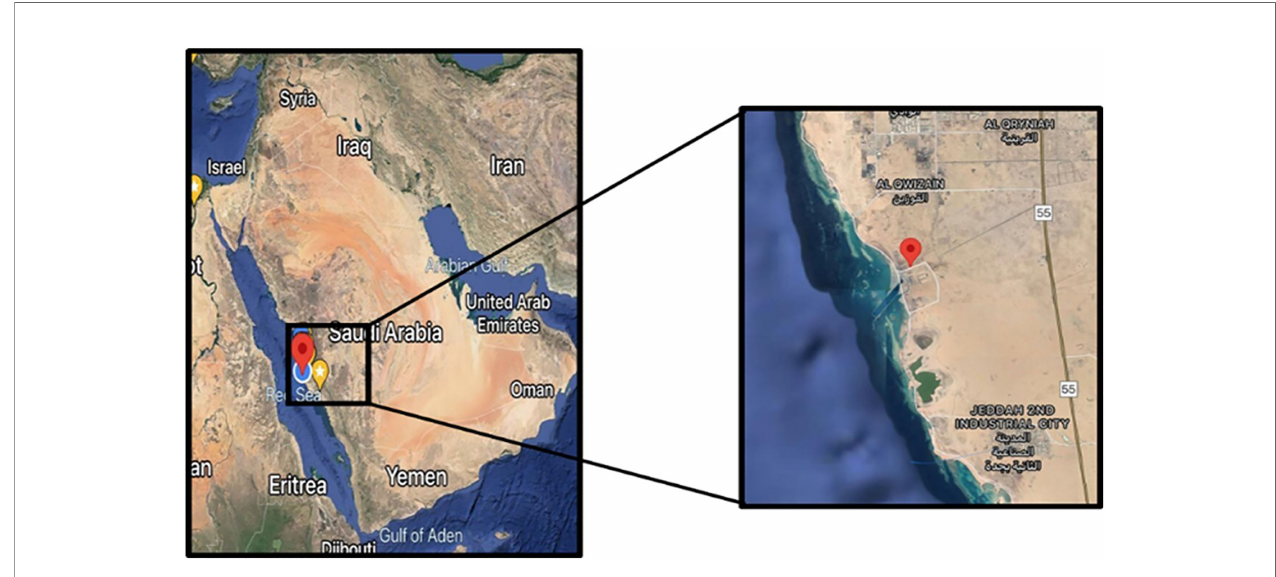
FIGURE 1 | Sampling